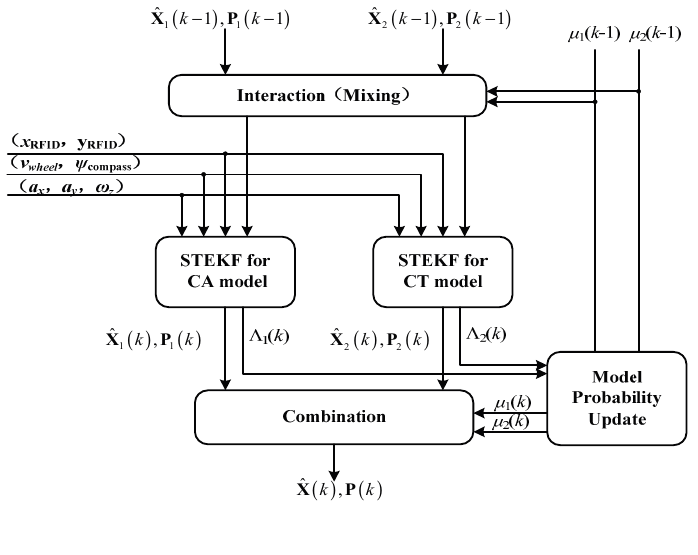
Figure 3. The IMM-STEKF